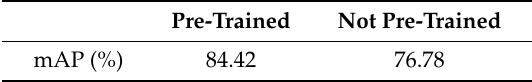
Table 8. Influence of model pre-training on performance.